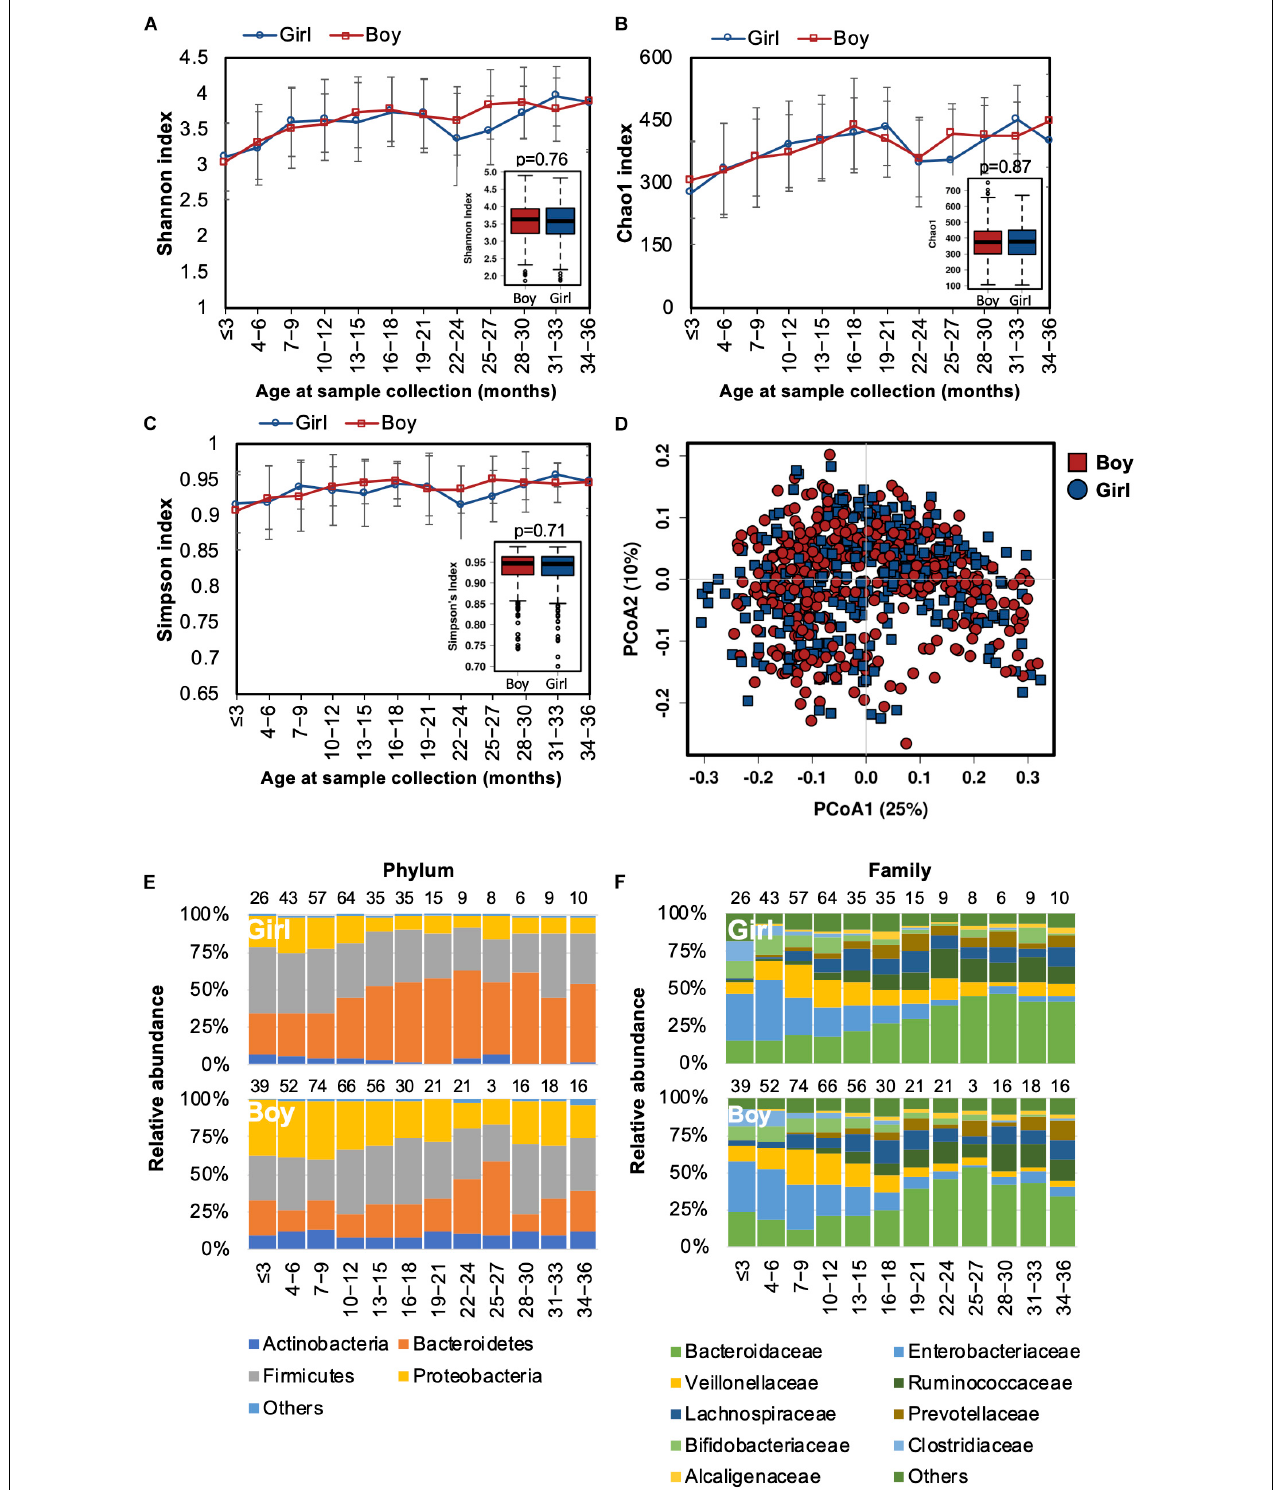
FIGURE 5 | Fecal microbiota diversity and composition for 729 children based on gender. Alpha diversity was calculated with (A) Shannon index, (B) Chao1, or (C) Simpson’s index, and showed no significant difference between genders. (D) PCoA showed no clear separation of the gut microbiota composition between boys and girls. Gender-stratified taxa summary composition of bacterial microbiota at the (E) phylum and (F) family levels. Number of children per age group is provided above bars.